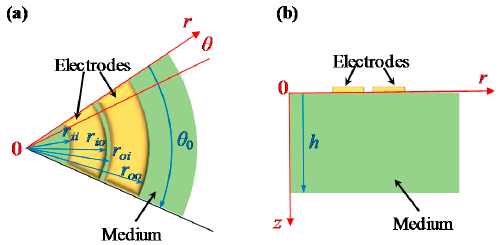
Figure 2. Schematic views of a segmented concentric annular coplanar capacitor: ( a ) top view, and ( b ) section view.